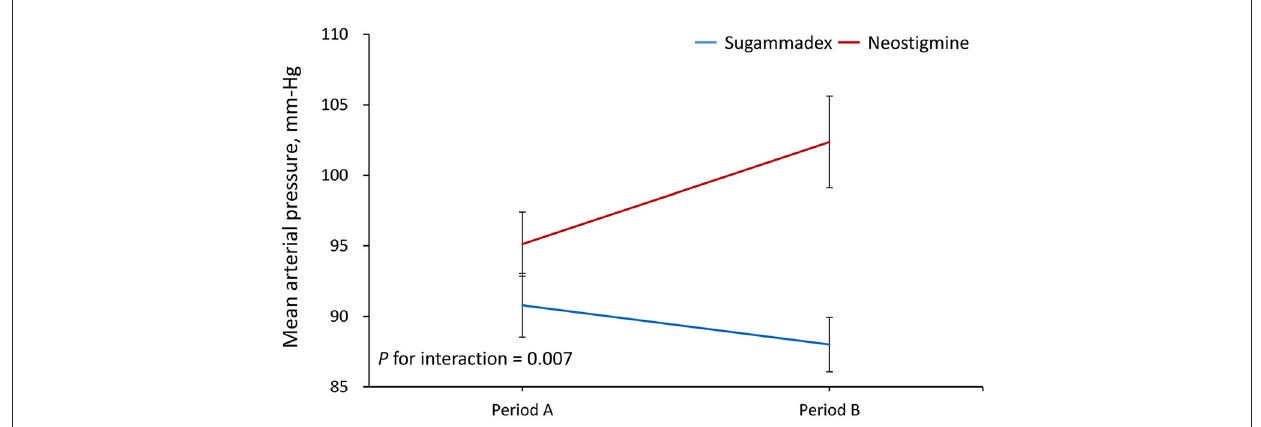
FIGURE1 Changes in mean arterial pressure from period A to B. Period A was defined as the average from reversal, and both 2 and 5min after reversal. Period B was defined as the average from 10 to 15min after